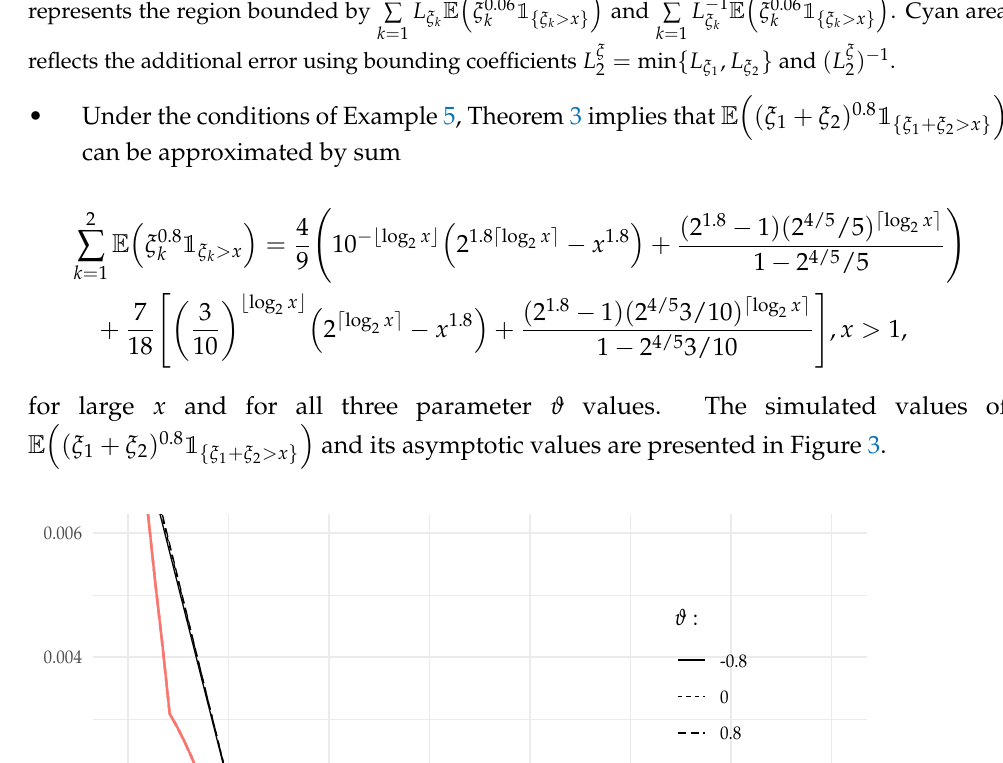
(cid:16) (cid:17) (cid:16) (cid:17) 2 2 E E 1 1 ∑ ∑ ξ 0.06 ξ 0.06 and . Cyan area L ξ L − 1 { ξ k > x } { ξ k > x } ξ k k k k k = 1 k = 1 = min { L } and ( L ξ ) − 1 . ξ 1 , L ξ 2 2 2